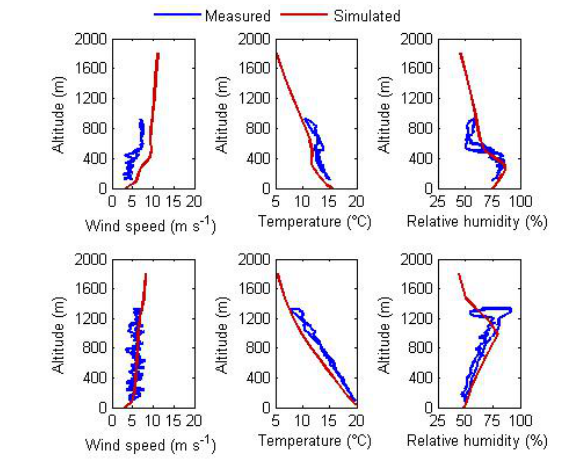
Figure 4. Measured and simulated vertical profiles of the atmosphere; morning profile No. 6 (upper plates) and noon profile No. 7 (lower plates). See Table 2 for details.